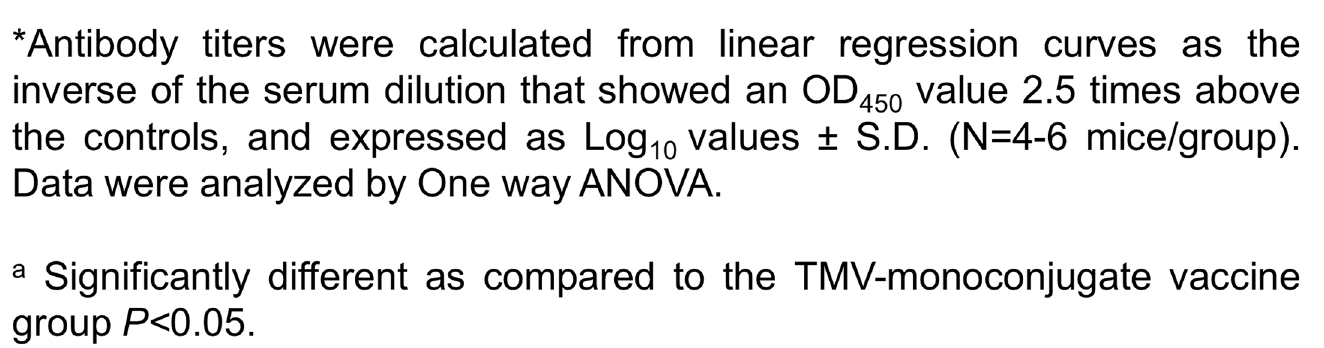
PLOS ONE | DOI:10.1371/journal.pone.0130858 June 22,